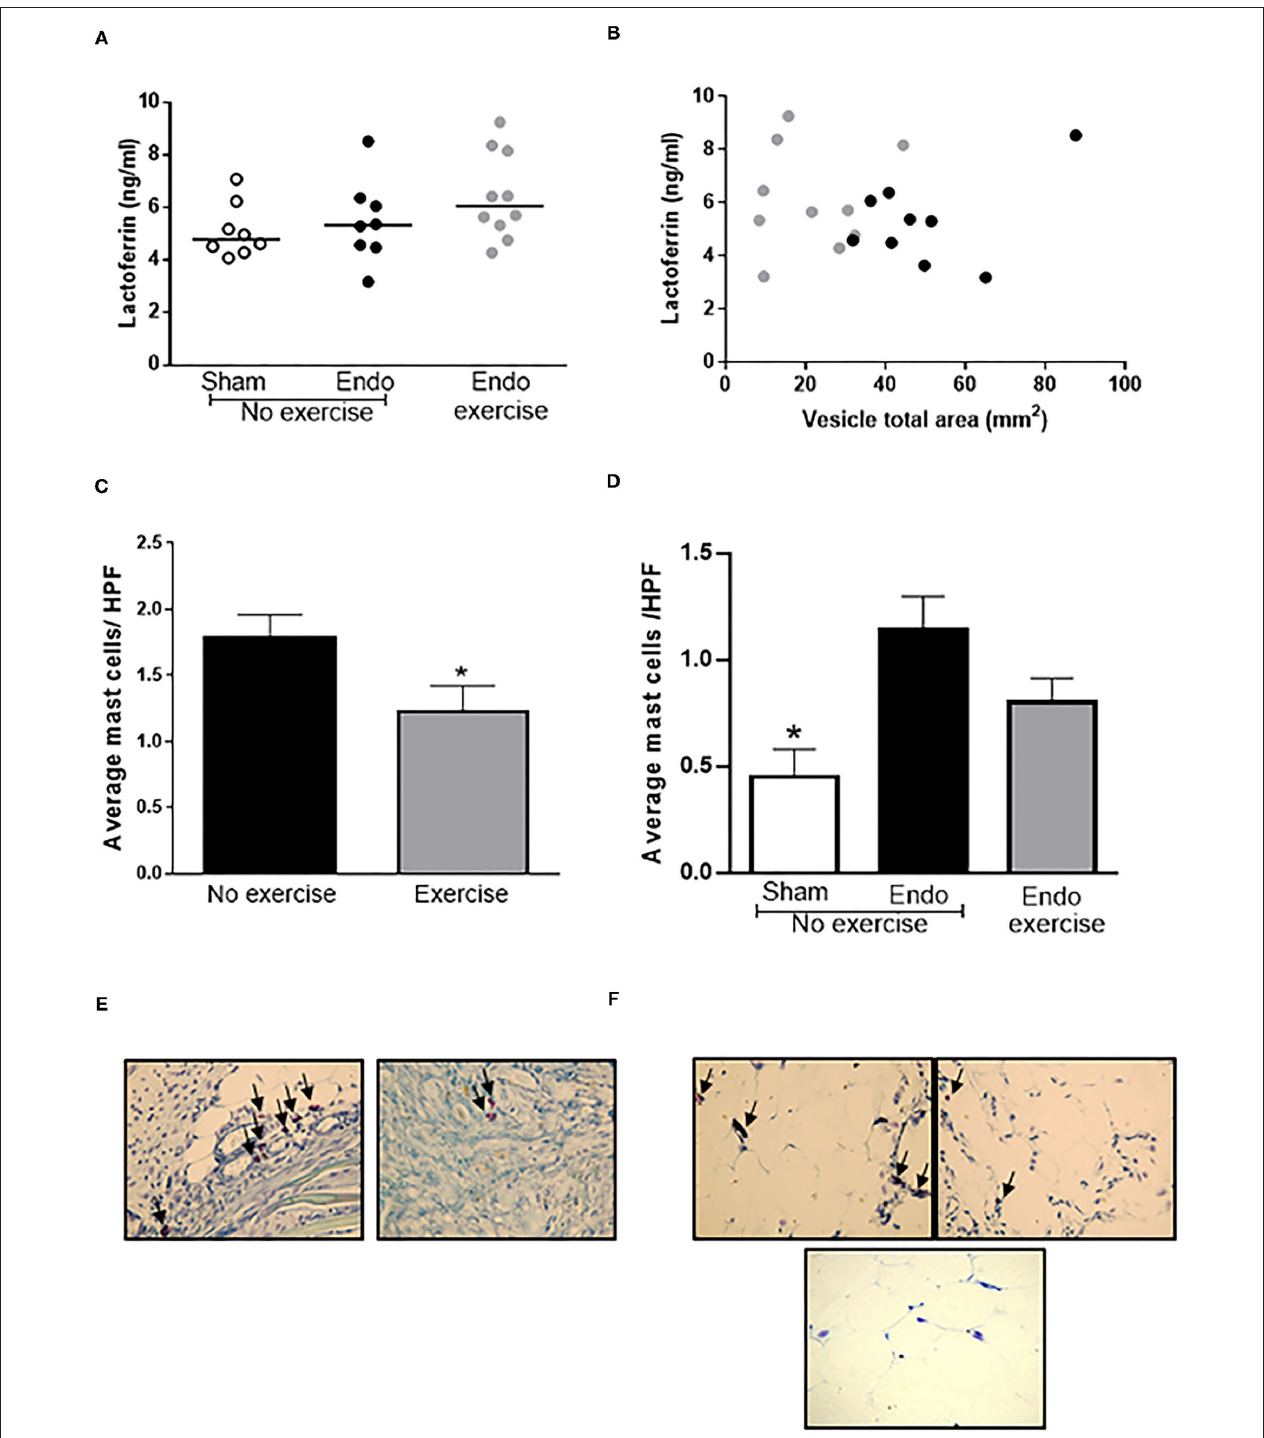
FIGURE 6 | Exercise decreased mast cell infiltration. (A) Higher levels of lactoferrin were found in the peritoneal fluid of Endo-Exercise animals and (B) these tended to correlate with smaller vesicles. (C) Exercise resulted in a significant decrease in the number of mast cells found in vesicles, with (D) a similar pattern observed in the mesenteric fat. Representative photos of mast cells in (E) vesicles and (F) mesenteric fat from (left to right) Endo-No exercise and Endo-Exercise animals (bottom), Sham-No Exercise x40 magnification ( n = 9–10 animals/group ± sem; * p < 0.05 compared to Endo-No exercise; black circles represent Endo-No exercise, gray circles represent Endo-Exercise; arrows indicate mast